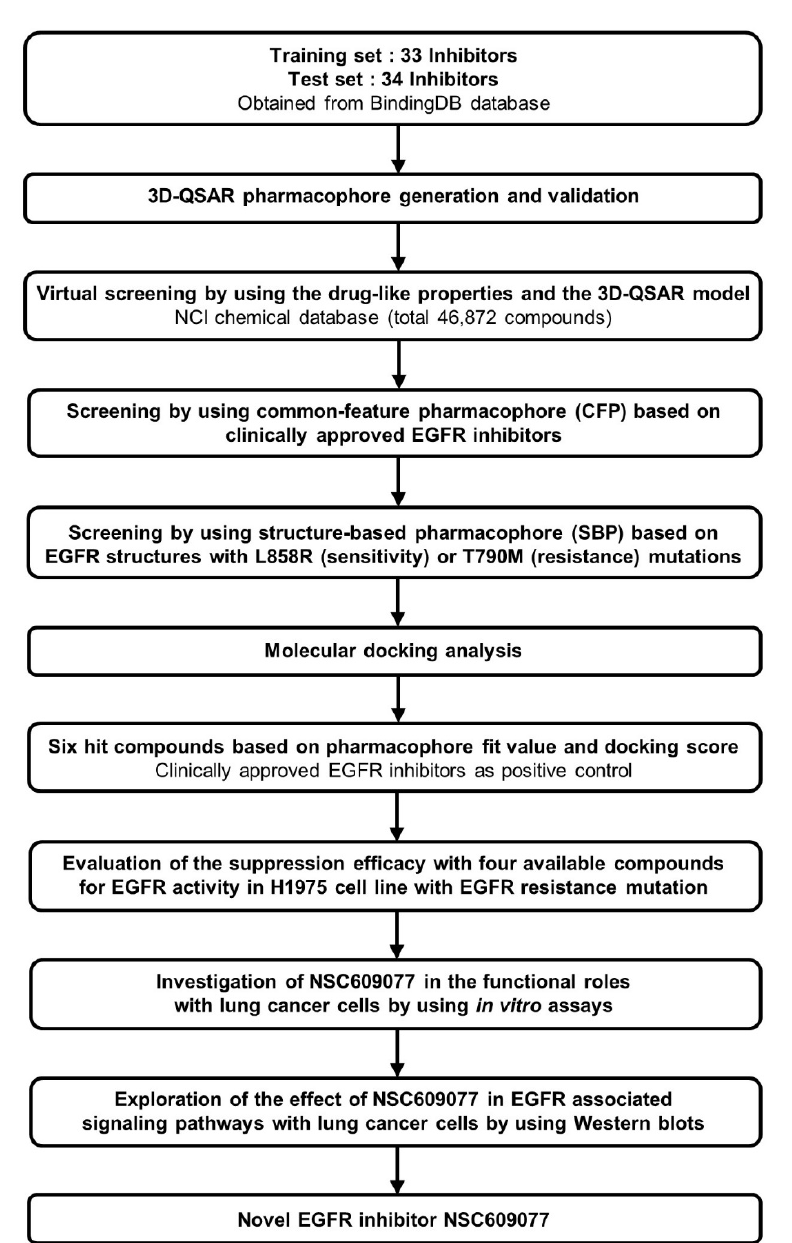
Figure 1. The overall scheme of multiple-stage pharmacophore-based virtual screening (PBVS) implemented for the identification of the novel EGFR inhibitor NSC609077. Abbreviations- 3D-QSAR: 3D quantitative structure-activity relationship, NCI: National Cancer Institute, EGFR : Epidermal growth factor